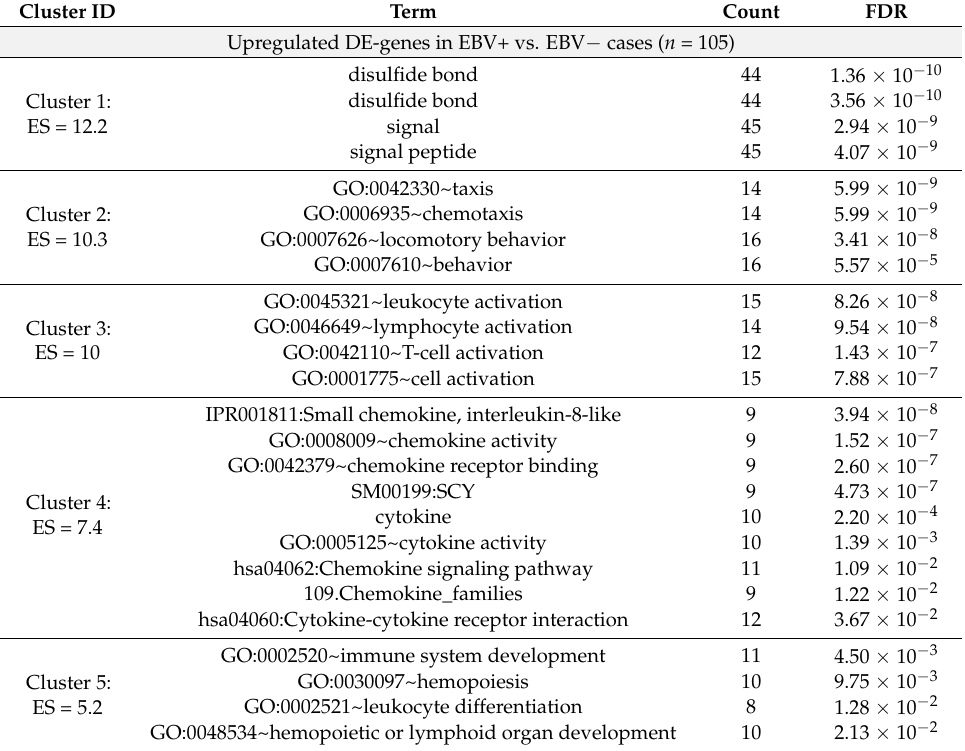
Table 5. Functional annotation clustering results for the 141 DE-genes upregulated in EBV+ cases. Six clusters of associated biological terms were detected for upregulated DE-genes and two clusters for downregulated DE-genes. Notice that some terms among clusters are not significantly enriched (FDR >